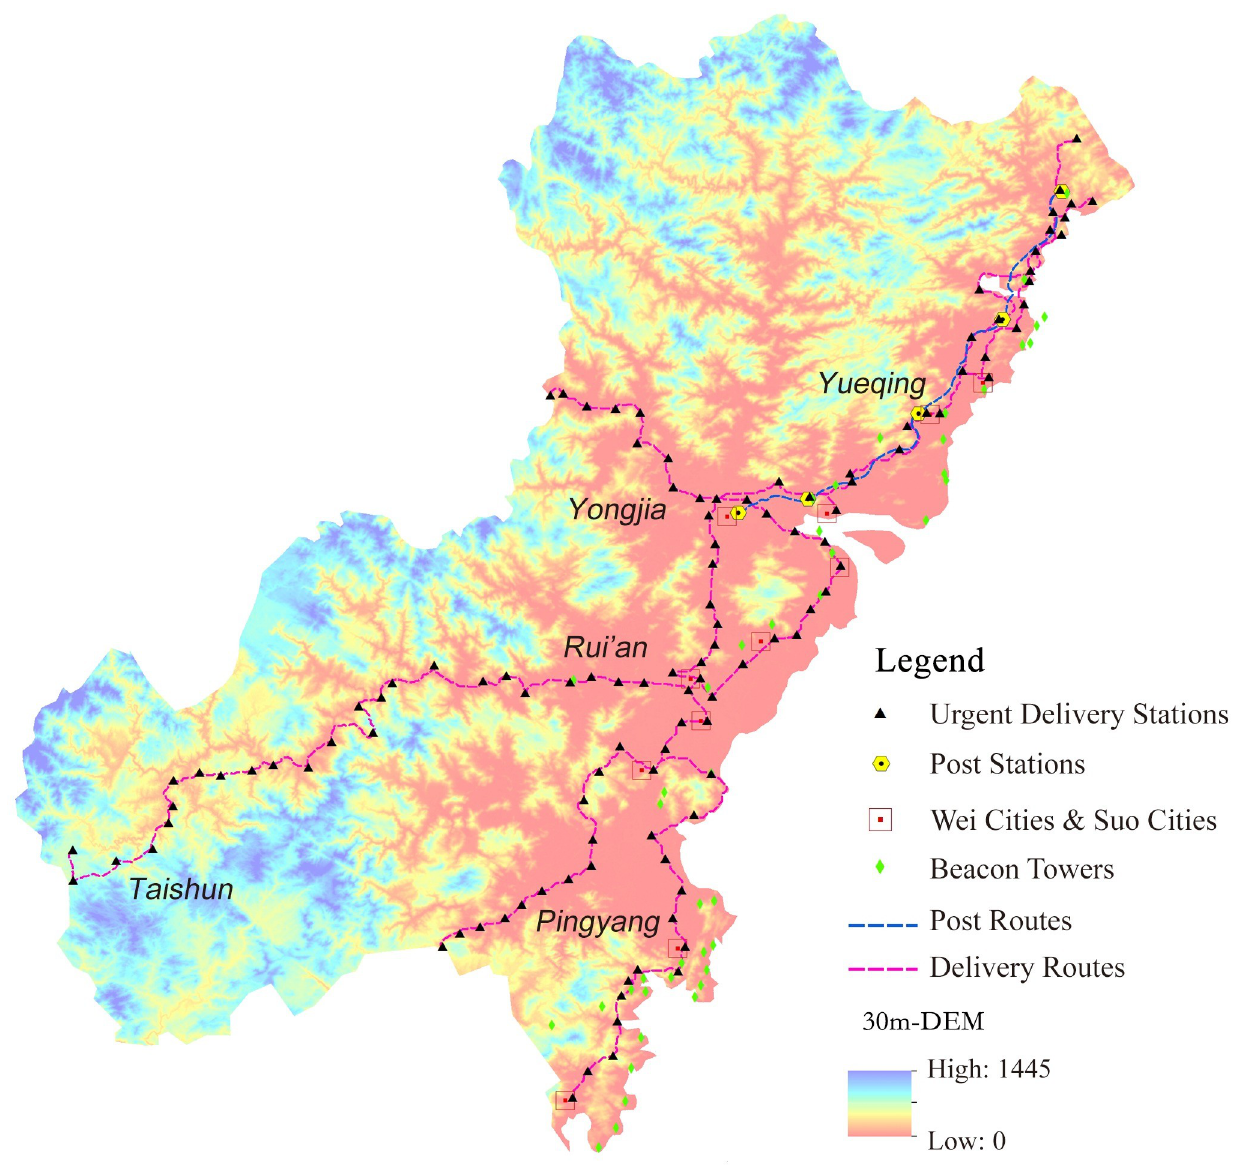
Fig 3. Spatial distributions of Wei cities, Suo cities, beacon towers, post stations and urgent delivery stations.